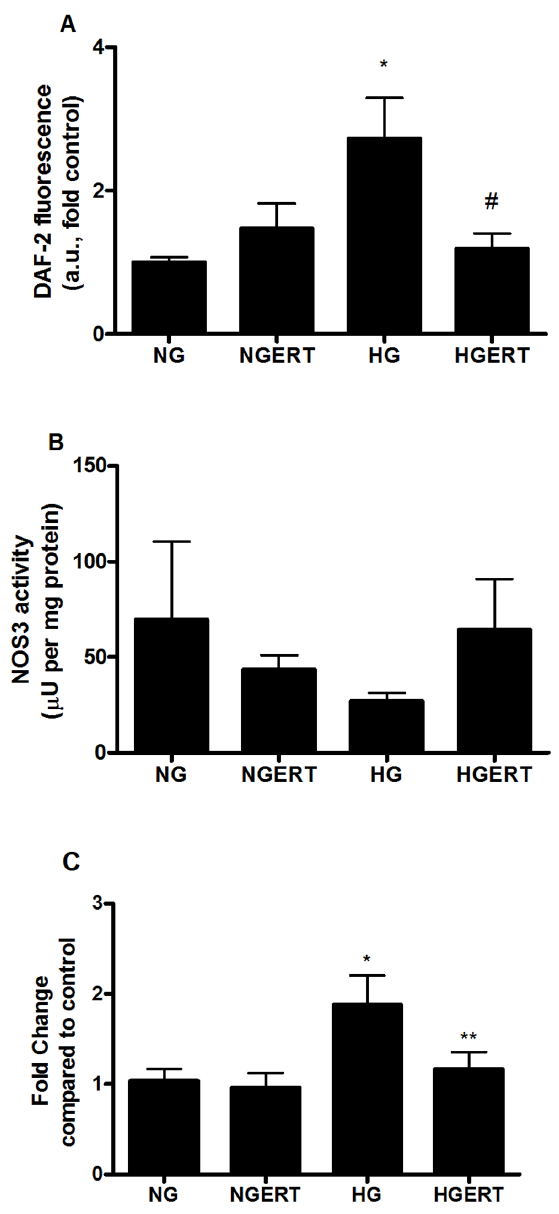
Figure 3. Effect on endothelial cell parameters. Effect of pre/co incubation with 5 mM erythritol (ERT) on HUVECS cultured in normal glucose (NG, 7 mM) or high glucose (HG, 30 mM) for 24 hours on NO release (A) NOS3 activity (B) NOS3 gene expression (C). Data are expressed as means 6 standard error of at least three independent experiments. *=p , 0.05 compared to NG; **=p , 0.05 compared to HG; # =p , 0.1 compared to HG.